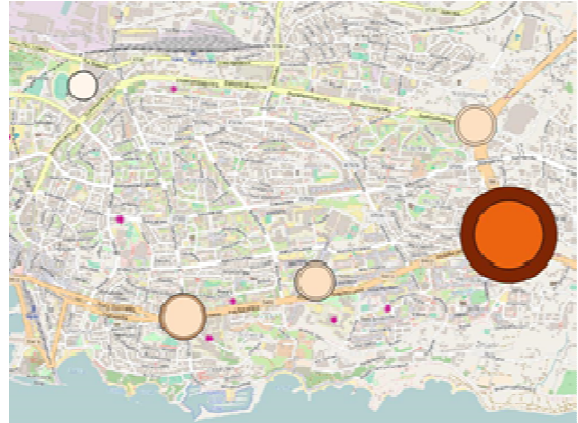
Figure 4: Point symbols showing the number of visitors per weeks (backdrop map © OpenStreetMap 2017)